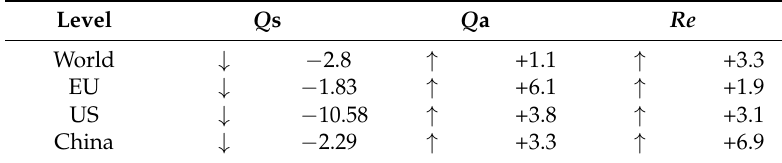
Table 3. Trends in the evolution of the analysed indicators 2015/2014